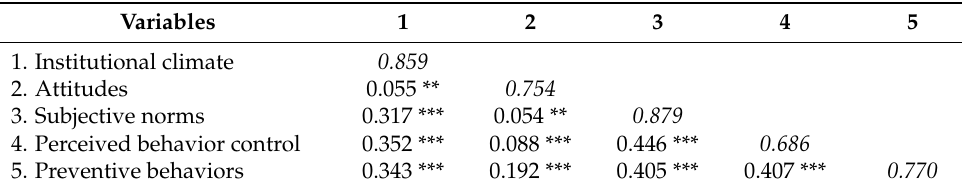
Table 4. Discriminant validity and correlation.